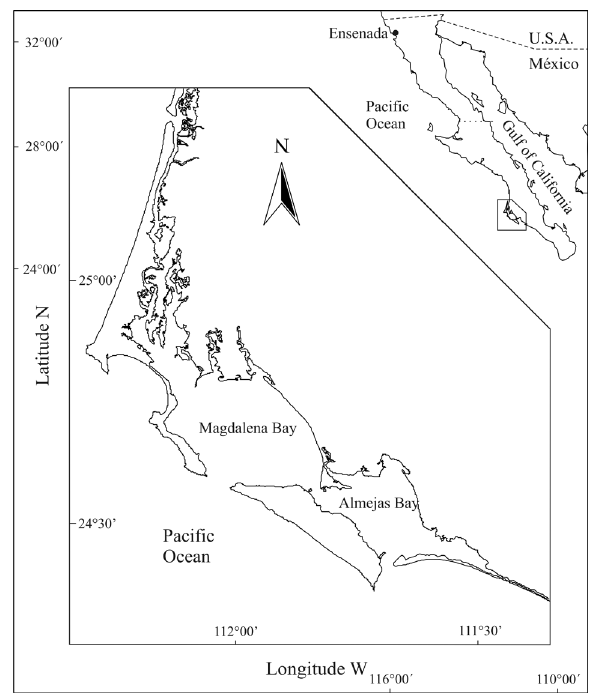
Fig . 1. – study area of the Pacific sardine ( Sardinops sagax caer- ulea ) fishery on the western coast of the Baja California peninsula,